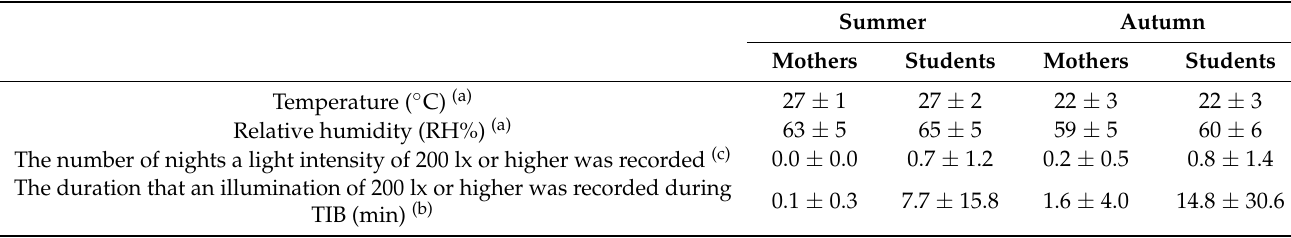
Table 3. The results of bedroom environmental conditions during TIB.